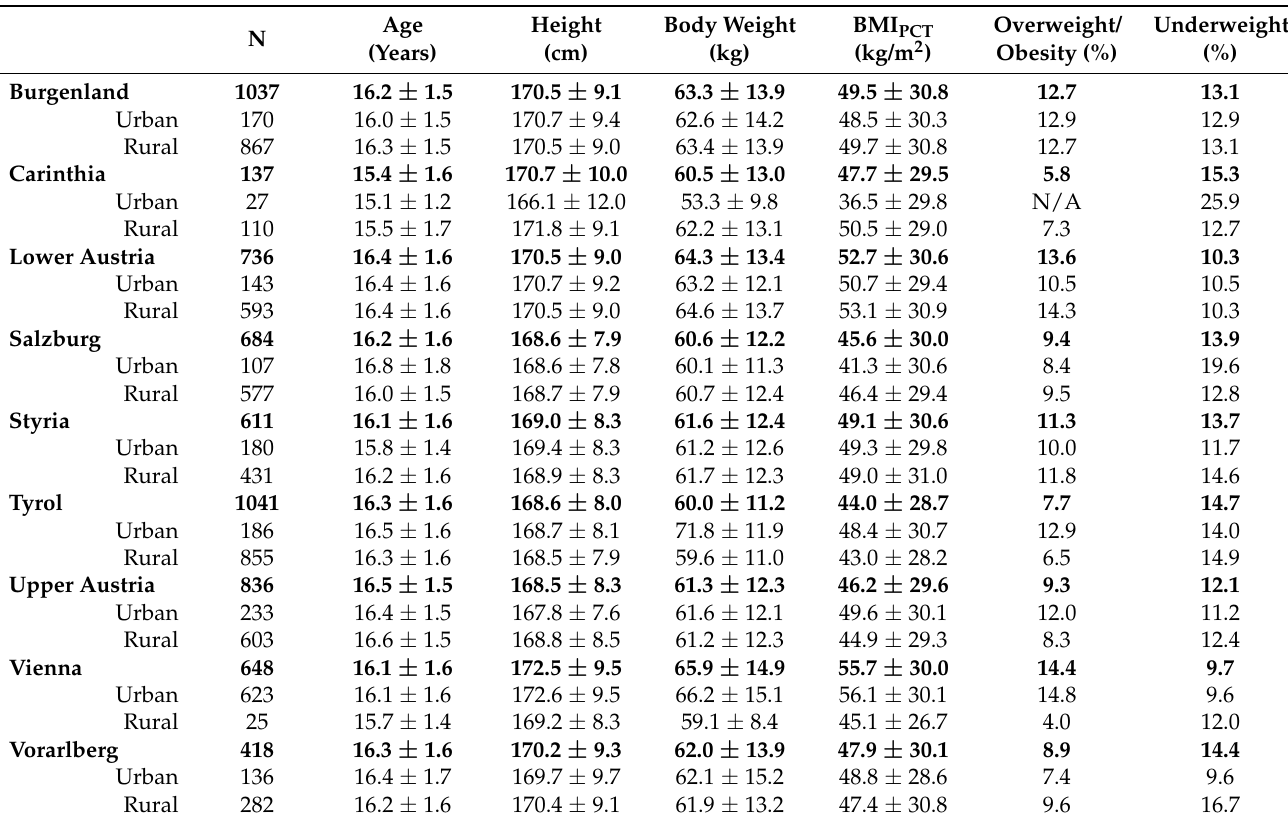
Table A2. Anthropometric Characteristics by federal state and living area in secondary level II pupils. Values are means ± SD and prevalence for weight